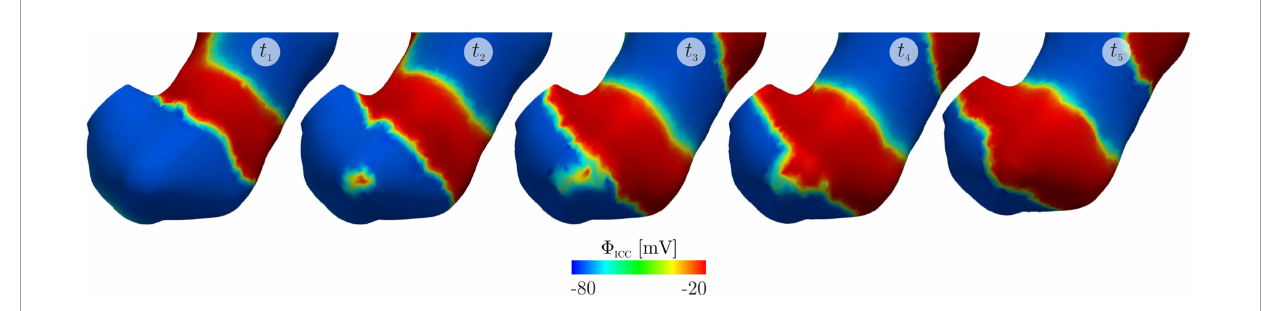
FIGURE3 An electromechanical model of gastric slow waves and contraction published by Klemm et al. (2023) reproduced from Klemm et al. (2023) licenced under CC-BY-NC-ND 4.0. The simulations show the emergence of an ectopic pacemaker of slow waves in the gastric antrum due to stretching and the subsequent change in slow waves and mechanical contractions at t1: 60 s, t2: 62 s, t3: 64 s, t4: 65 s and t5: 69